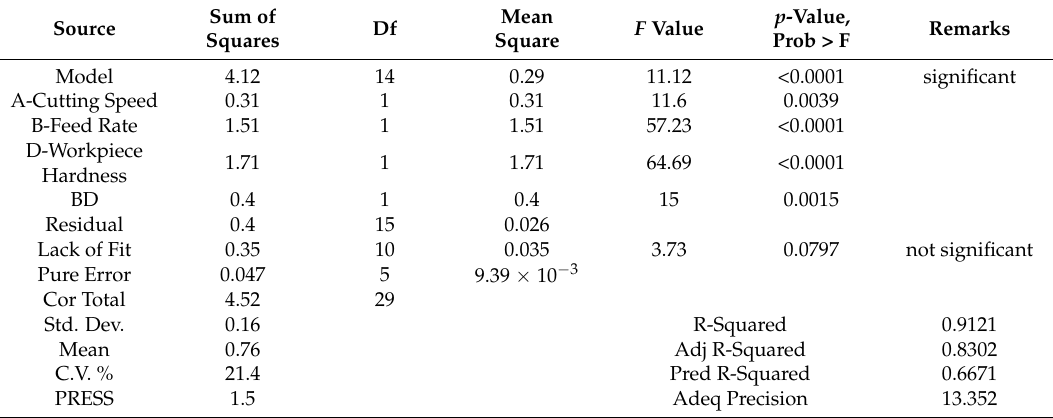
Table 7. ANOVA model of Surface Roughness for CBN-III